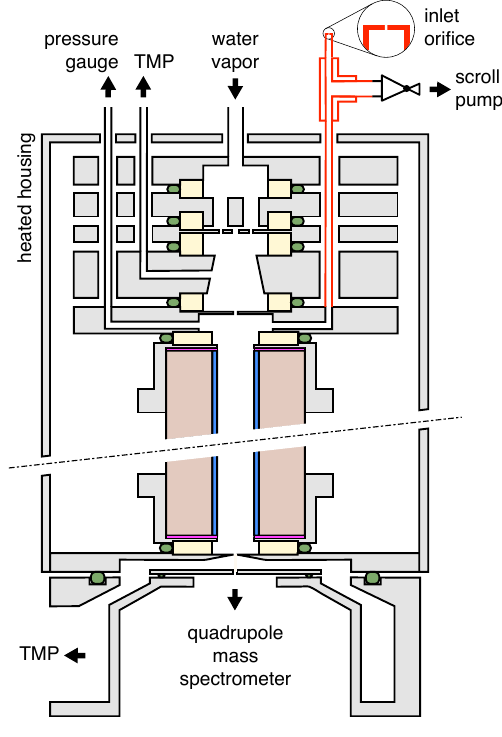
Fig. 1. Scheme of the ion source and the resistive glass drift tube in the HT-PTR-MS. Material color-coding: stainless steel (grey), PEEK (yellow), Kalrez ® (green), flexible graphite (magenta), re- sistive glass (blue), MACOR ® (light brown), passivated stainless steel (red). TMP: turbomolecular pump.